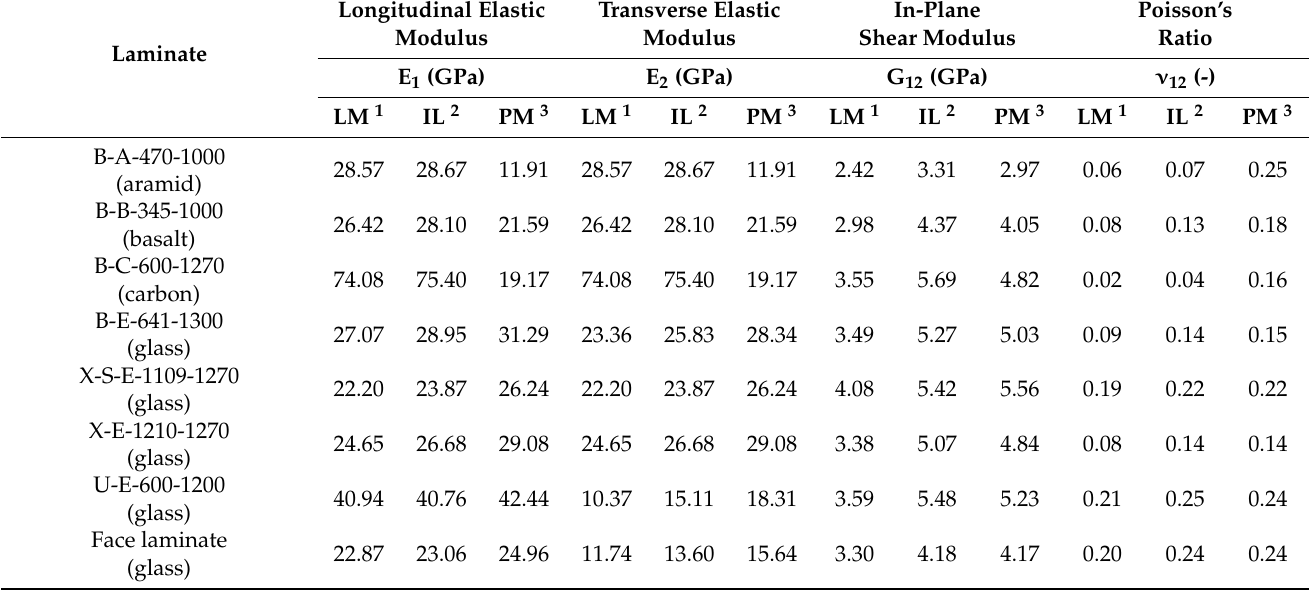
Table 8. The calculated material constants for all types of